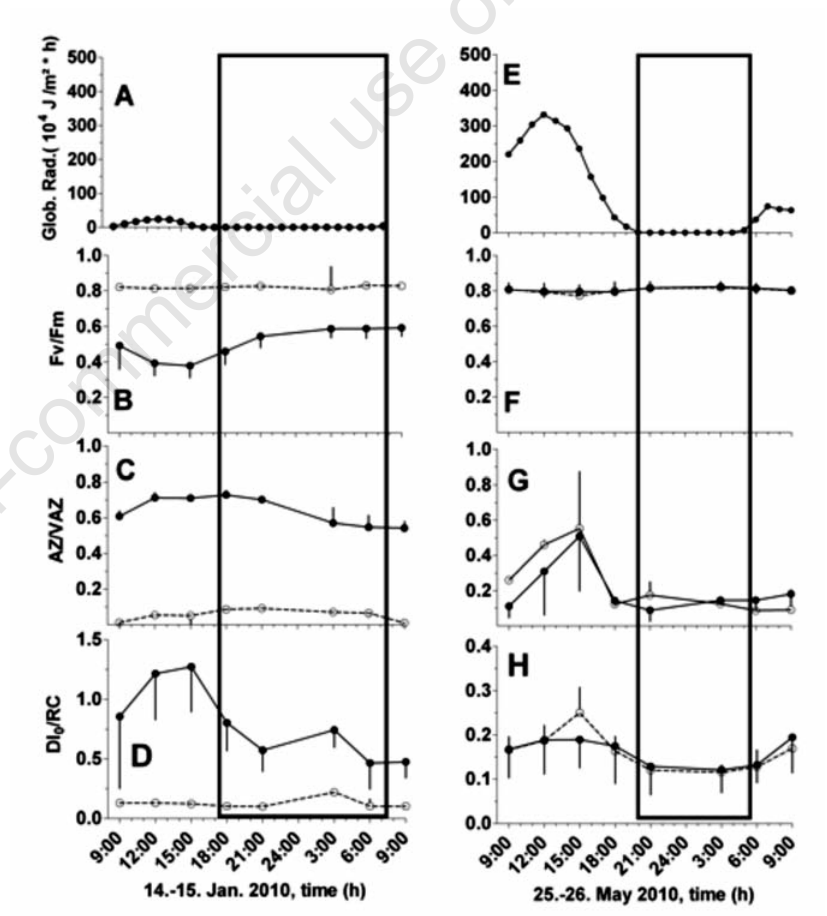
Figure 1. Diurnal courses of global radiation at Geisenheim, chl fluorescence parameters and AZ/VAZ in Q. ilex growing outdoors ( l , FR) or in a frost-free foliar greenhouse ( ° , FRFF) at Frankfurt on 14.01.2010 (1A-D, T=-3° to +1°C, heavily clouded) and on 25.05.2010 (1E-H, T=+13° to +25°C, very sunny). Night periods are denoted by the black rectangles. Means±SD; n=10 (AZ/VAZ: n=2) leaves (technical replicates) per three trees (biological replicates) analysed on each location. A, anthera; Z, zeaxanthin; V, viola; FR, Frankfurt; FRFF, Frankfurt,